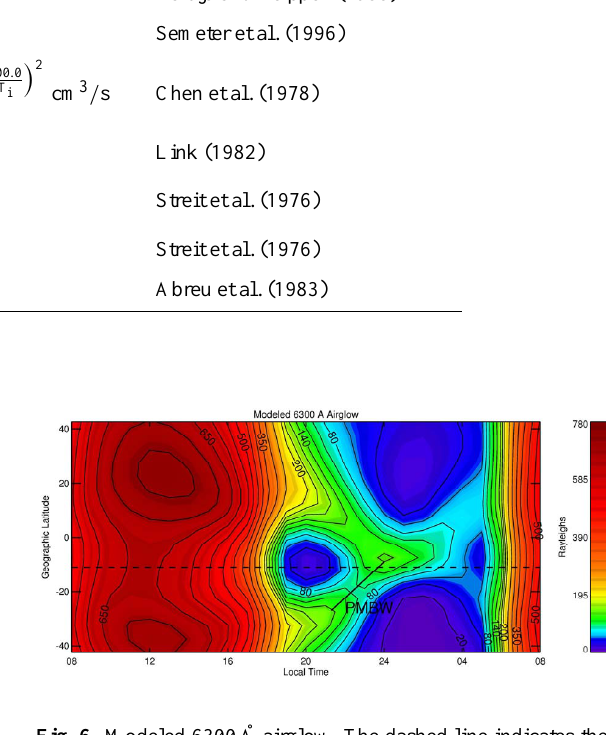
Fig. 6. Modeled 6300 ˚A airglow. The dashed line indicates the lo- cation of the geomagnetic equator. The PMBW event and its equa- torward propagation are illustrated by the black line. Note of the lack of an MBW event in the